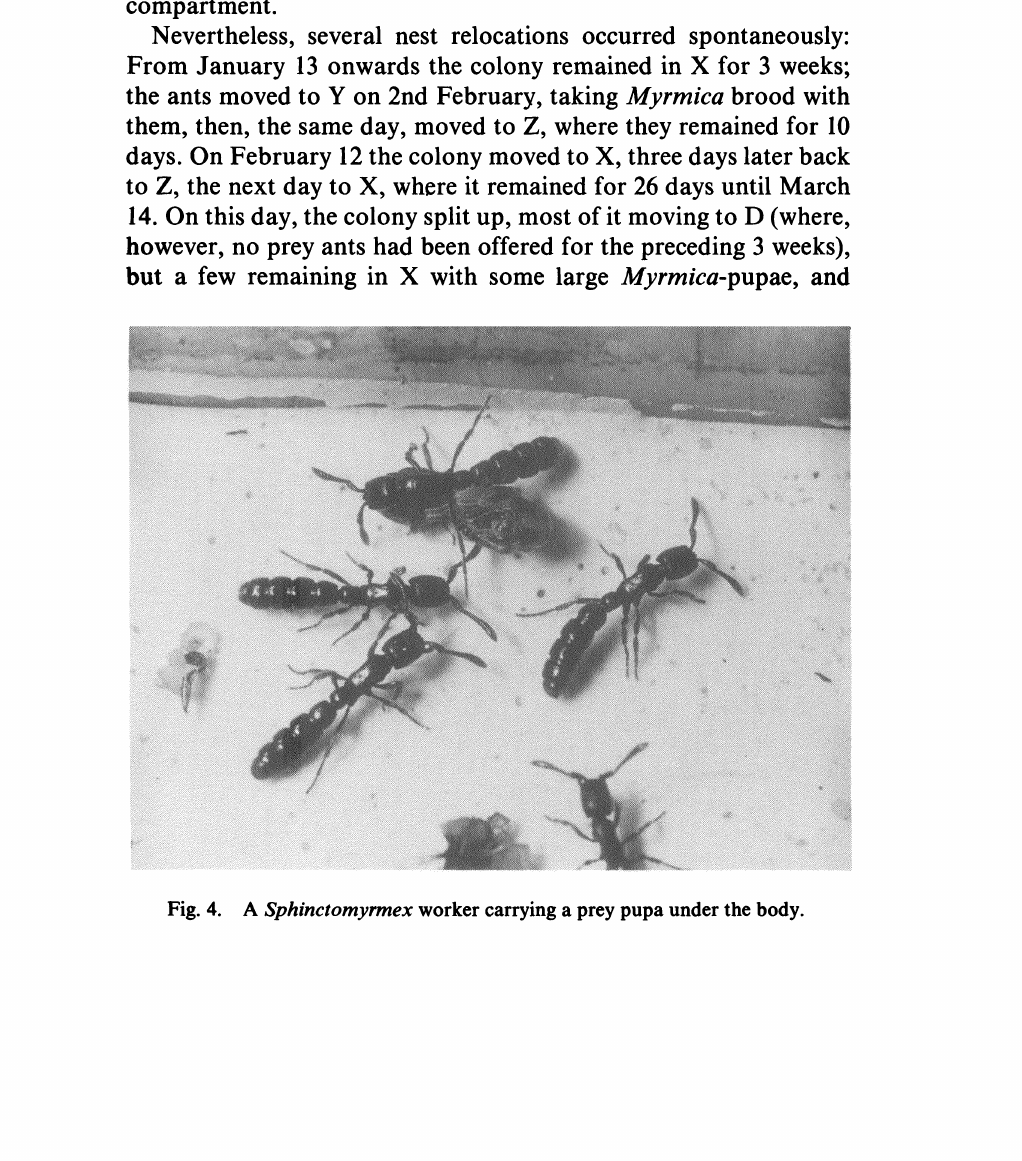
Fig. 4. A Sphinctomyrmex worker carrying a prey pupa under the